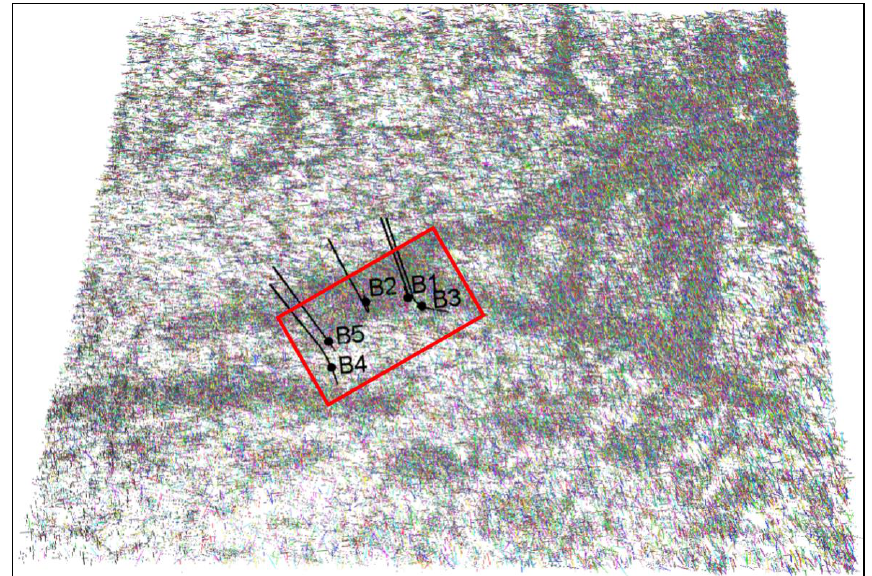
Figure 15. Full-field DFN model for the entire reservoir. The red square delimits the B-P gas model employed for the following water intrusion characterization.